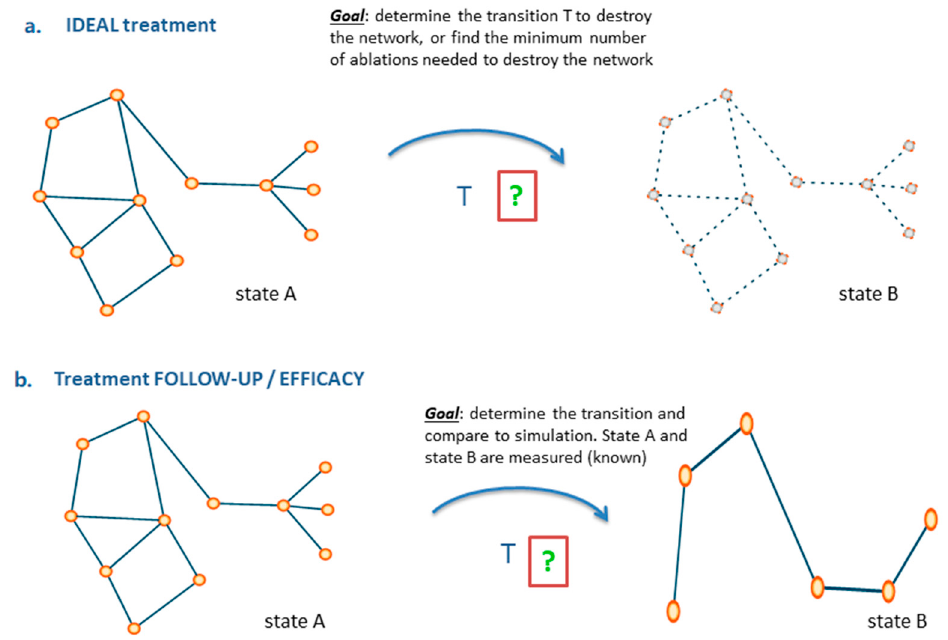
Figure 5. Use of networks to determine ideal treatment ( a ) and treatment follow-up ( b ). In the top panel the goal is to solve the tumor by acting on its nodes. Assuming that state A had defined the tumor nodes, state B measures the effects of ablations that destroy the communications between such nodes. The bottom panel measures the efficacy of treatment by tracking the shape of states (ex-ante and ex-post compared to treatment).